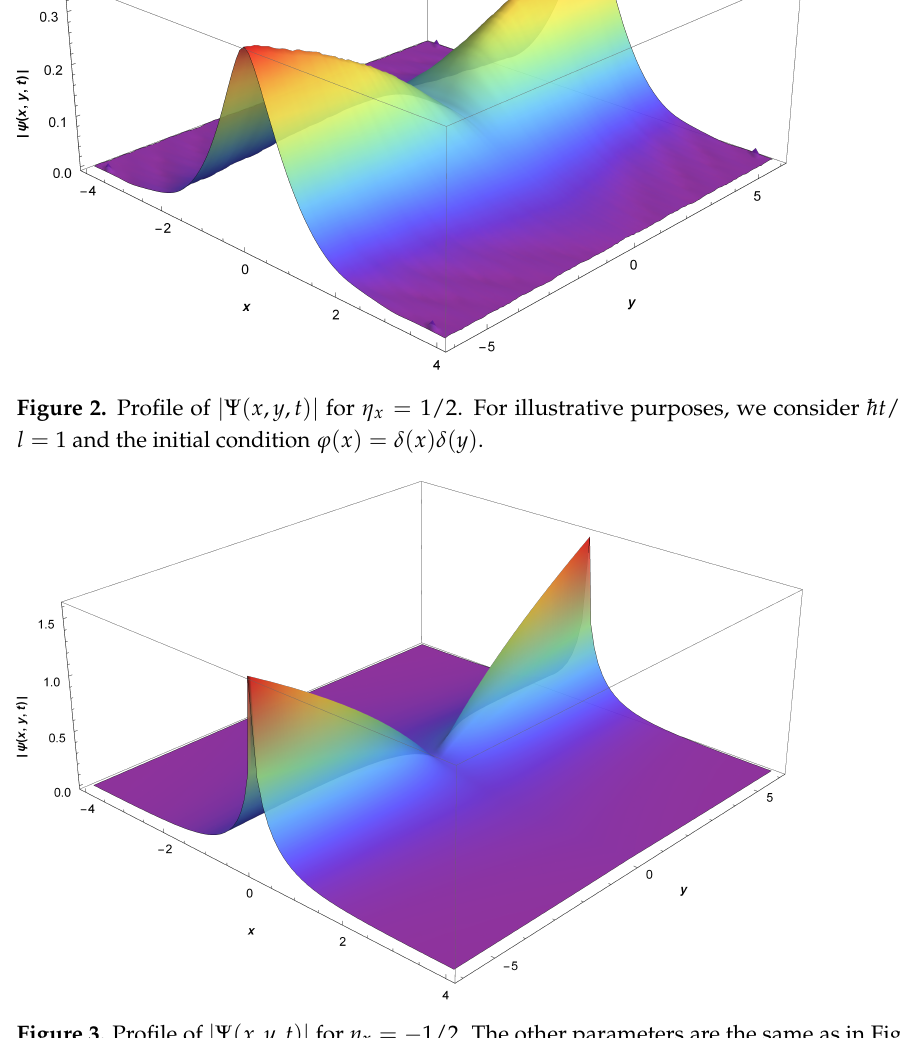
Figure 3. Profile of | Ψ ( x , y , t ) | for η x = − 1/2. The other parameters are the same as in Figure